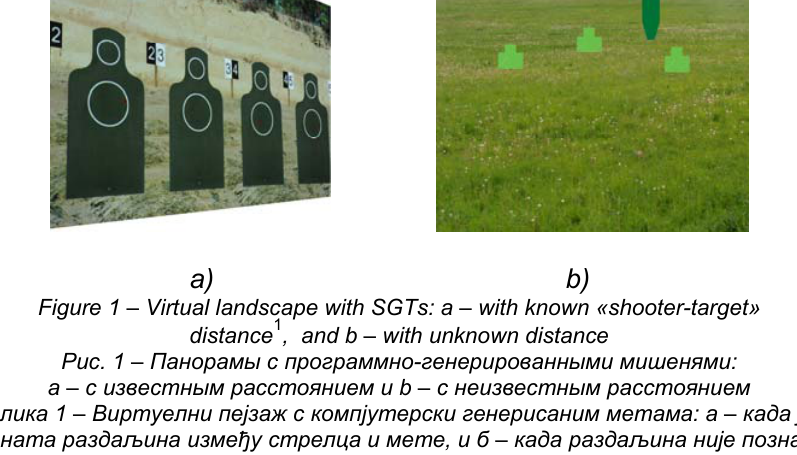
Figure 1 – Virtual landscape with SGTs: a – with known «shooter-target» distance 1 , and b – with unknown